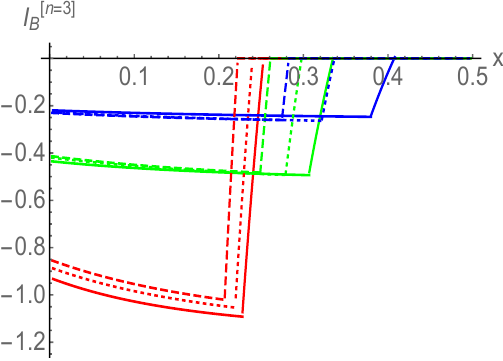
Figure 21 . Tri-partite information I [ n =3] function of x for various values of ‘ and T at (cid:22) = 0. Here red, green and blue curves correspond to ‘ = 0 : 3, 0 : 4 and 0 : 5 respectively. The solid, dotted and dashed curves correspond to T=T c = 1 : 2, 1 : 6 and 2 : 0 respectively. In units